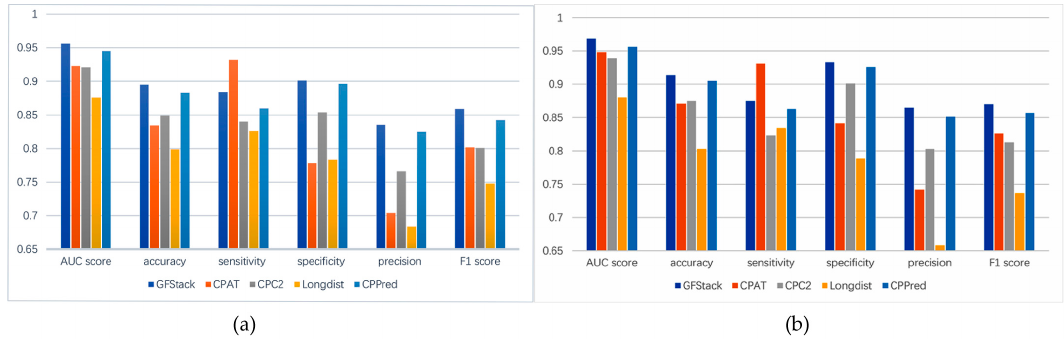
Figure 3. The performance comparison of PredLnc-GFStack and CPAT, CPC2, Longdist, CPPred on Human-Main and Mouse-Main. ( a ) The results of all models evaluated by 10-CV on Human-Main. ( b )The results of all models evaluated by 10-CV on Mouse-Main.